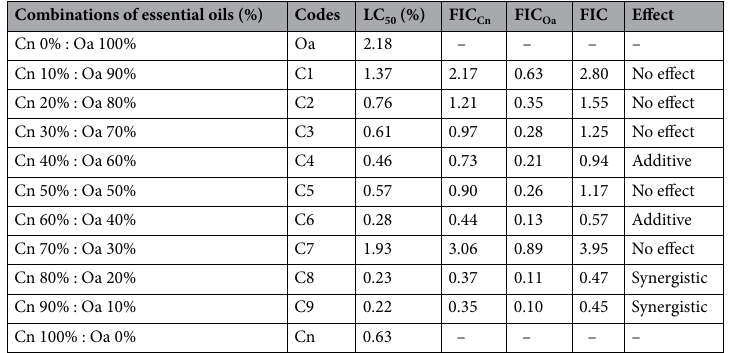
Table 6. Effects of combinations of essential oils of Cymbopogon nardus (Cn) and Ocimum americanum (Oa) on adults of Anopheles gambiae susceptible strain (Kisumu) and type of interaction (n = 125 adult). LC 50 : lethal concentration for 50% mortality FIC: FIC Cn + FIC Oa ; Synergistic: FIC < 0.5; Additive; 05 ≤ FIC ≤ 1; No effect: 1 ≤ FIC ≤ 4; Antagonistic: FIC > 4; Cn: Cymbopogon nardus ; Oa : Ocimum americanum; % : percentage.